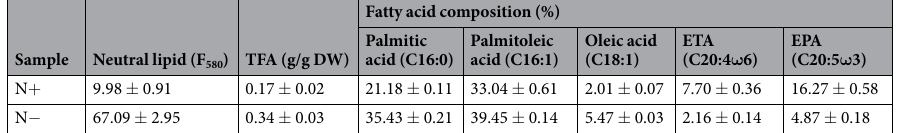
Table 2. Changes in neutral lipid and total fatty acid (TFA) contents, and fatty acid compositions from N. salina cells grown under nitrogen-rich (N + ) and nitrogen-depleted (N − ) conditions for 2 days. Neutral lipid content was estimated by Nile Red fluorescence amplitude at 580 nm excited at 430 nm. Only significantly different fatty acid species between the two samples are represented. Data are expressed as the average of three biological replicates ± SD. Each sample was significantly different from the other (independent two-tailed t -test,